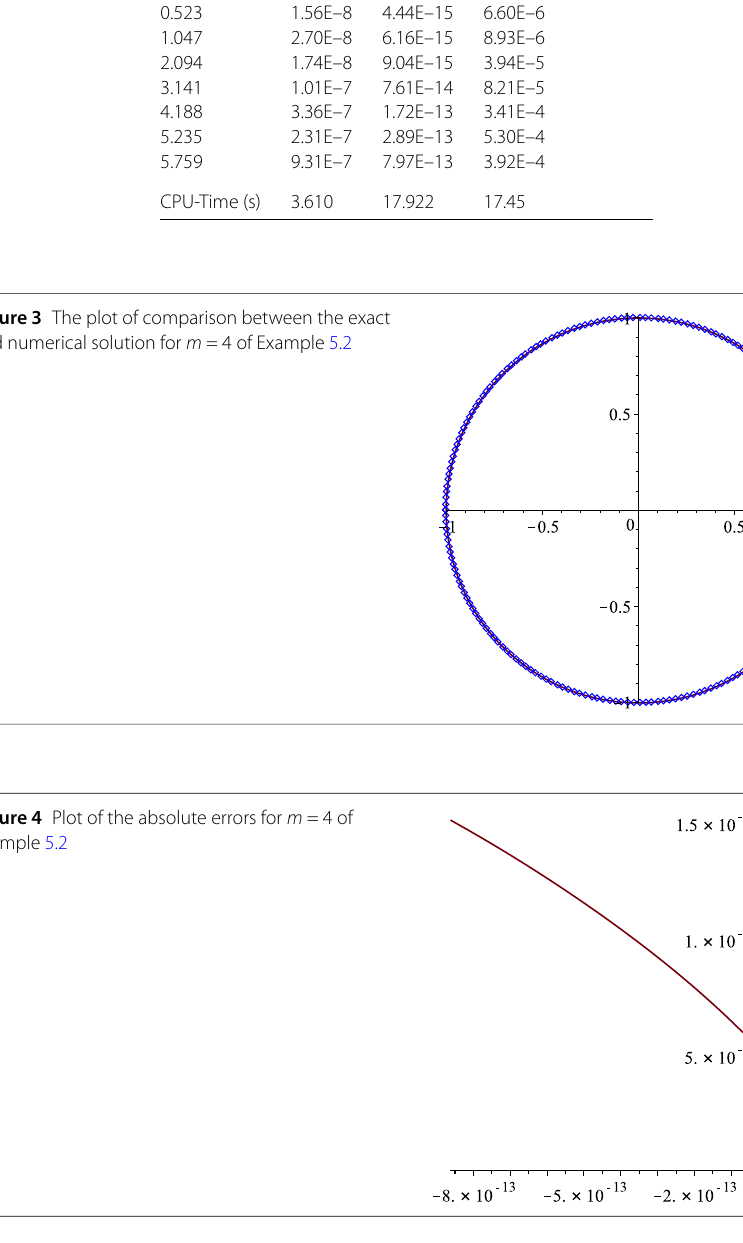
Table 2 Numerical results of Example 5.2